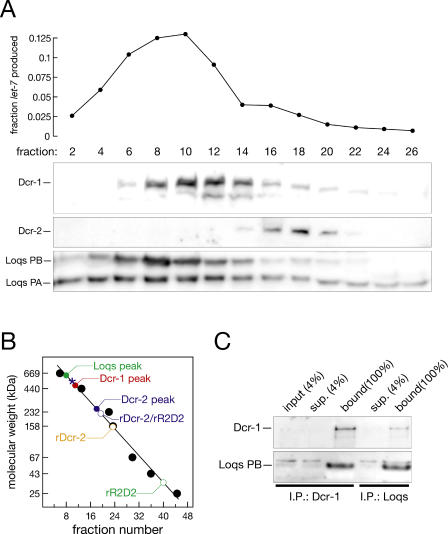
Analysis of Complexes Containing Pre-miRNA Processing Activity, Dcr-1, and Loqs(A) S2 cell lysate was fractionated by gel filtration chromatography and analyzed for pre-let-7 processing activity, and Dcr-1, Dcr-2, and Loqs proteins.(B) The sizes of the distinct complexes containing Loqs (∼630 kDa), Dcr-1 (∼480 kDa), and Dcr-2 (∼230 kDa) and the broad complex containing pre-miRNA processing activity (∼525 kDa) were estimated using molecular weight standards (thyroglobulin, 669 kDa; ferritin, 440 kDa; catalase, 232 kDa; aldolase, 158 kDa; bovine serum albumin, 67 kDa; ovalbumin, 43 kDa; chymotrypsinogen A, 25 kDa) and recombinant Dcr-2 and R2D2 proteins (rDcr-2 and rR2D2). The blue asterisk denotes the peak of pre-let-7 processing activity detected in (A).(C) Fractions containing the Dcr-1 peak were pooled and immunoprecipitated with either anti-Dcr-1 or anti-Loqs antibodies. Western blotting with anti-Dcr-1 and anti-Loqs antibodies demonstrated that Dcr-1 and Loqs remained associated through gel filtration chromatography.